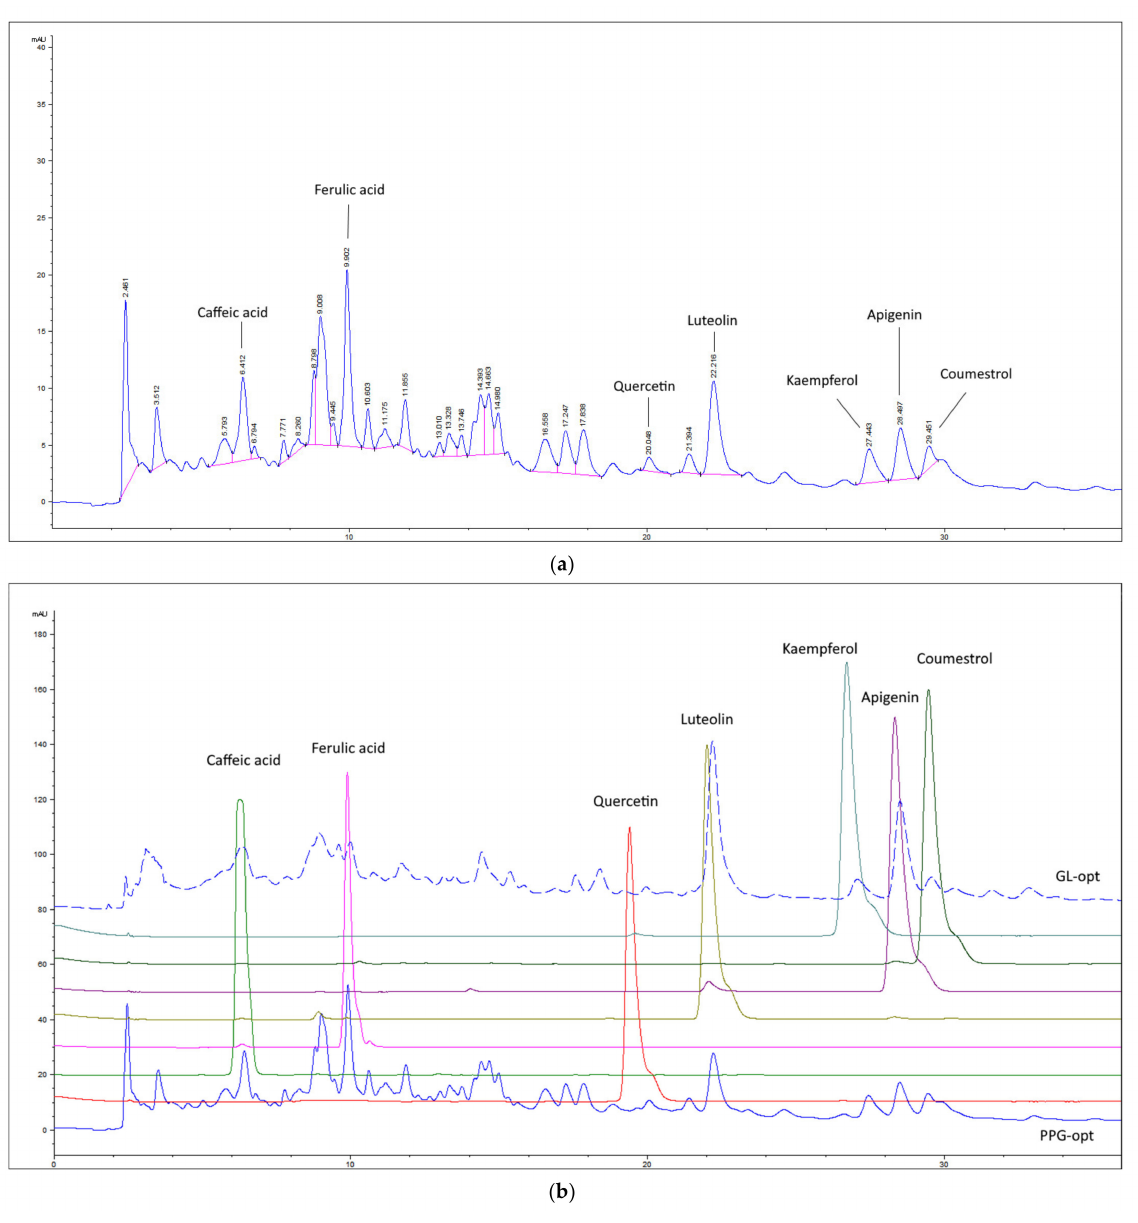
Figure A1. An example of a ) chromatogram with peak annotations of the detected compounds (PPG-opt after 100 ◦ C hydrolysis recorded at 320 nm using the method for determination of flavonoids and phenolic acids; details in Materials and Methods section) and b ) chromatograms of PPG-opt, GL-opt and the phenolic standards in 2D signal overlay recorded in the same HPLC